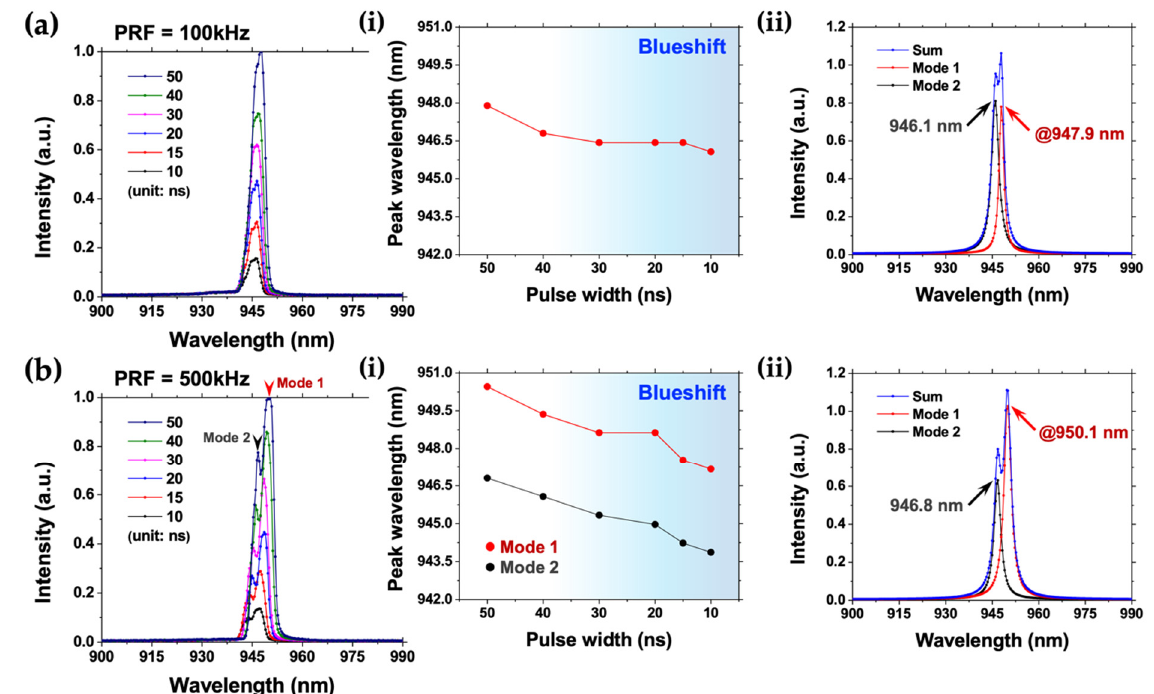
Figure 5. Light emission spectra of the employed PCSEL operated with fixed pulse repetition frequencies of 100 kHz and 500 kHz, respectively. ( a ) Light emission spectra of the PCSEL operated at 100 kHz with a series of pulse widths. The shorter pulse width, the bluer center wavelength. Insets: ( i ) Corresponding center wavelengths extracted from ( a ). While the pulse width is shrunk from 50 ns to 10 ns, a blueshift from 947.9 nm to 946.07 nm can be observed. ( ii ) Corresponding peak deconvolution of the PCSEL operated at 100 kHz with a pulse width of 50 ns. An implicit dual-mode phenomenon can be observed. For Mode 1 and Mode 2, the corresponding center wavelengths are 947.9 nm and 946.1 nm, respectively. ( b ) Light emission spectra of the PCSEL operated at 500 kHz with a series of pulse widths. Additionally, two modes, namely Mode 1 and Mode 2, can be discerned from the spectra. Insets: ( i ) Corresponding center wavelengths extracted from ( b ). While the pulse width is shrunk from 50 ns to 10 ns, blueshifts from 950.46 nm to 947.17 nm and 946.8 nm to 943.87 nm can be observed for Mode 1 and Mode 2, respectively. ( ii ) Corresponding peak deconvolution of the PCSEL operated at 500 kHz with a pulse width of 50 ns. A distinct dual-mode phenomenon can be recognized for Mode 1 and Mode 2 with the corresponding center wavelengths of 950.1 nm and 946.8 nm, respectively.